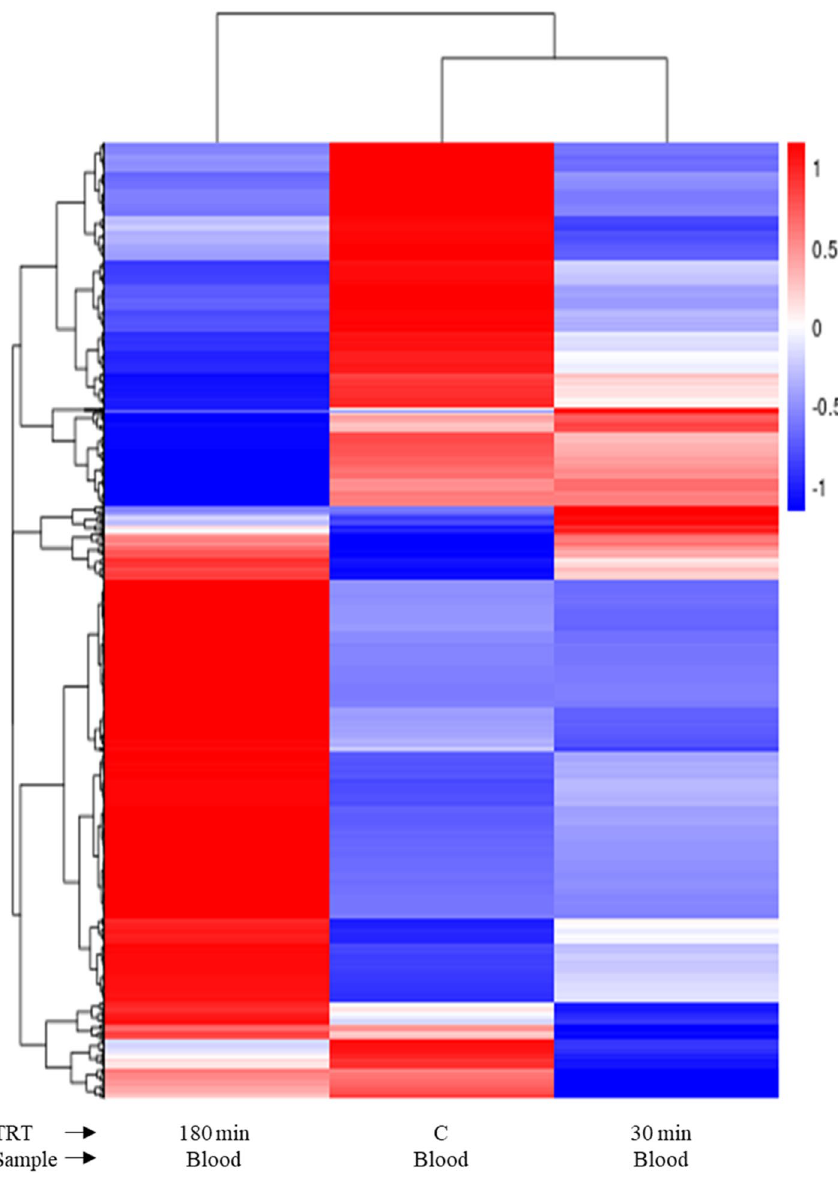
Figure 6. Heat map of differentially expressed genes in blood samples from goats subjected to stress treatments (TRT: control, C = not transported but held in pens; 30 min = transported for 30 min; or 180 min = transported for 180